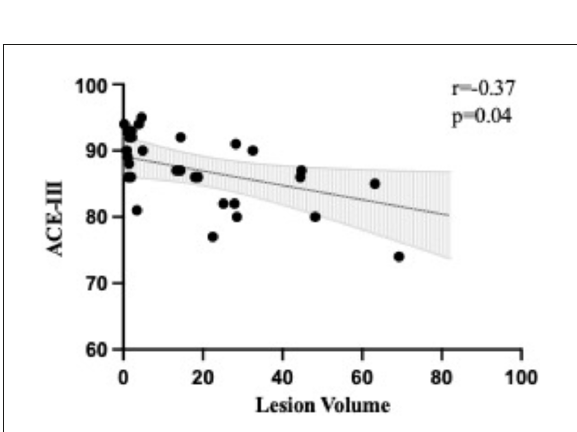
FIGURE6 The association between global cognitive function and lesion volume in patients with cerebellar